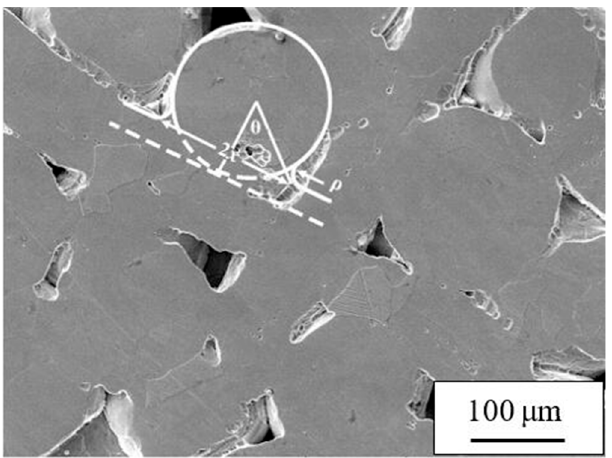
Figure 4. The ball-plate model on the surface of the sample: the sintering temperature is 900 °C and the sintering pressure is 20 MPa.